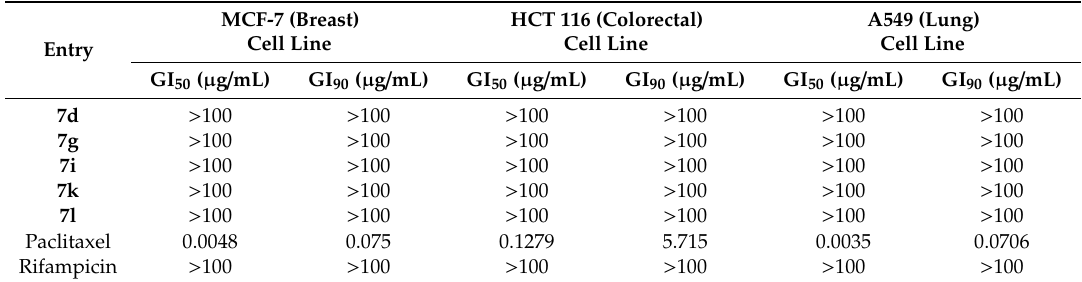
Table 2. In vitro cytotoxicity of selected 4-thiazolidinone derivatives.